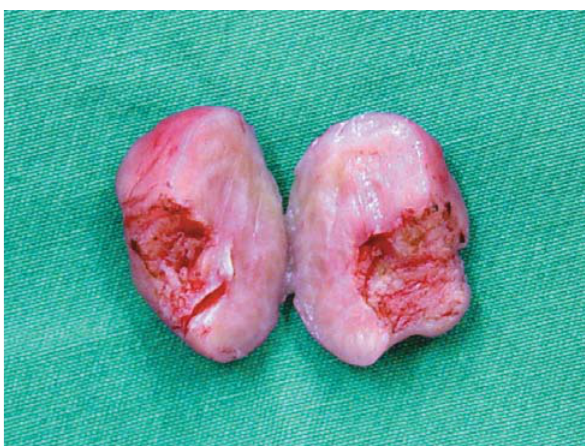
Fig. 3 – Análise macroscópica da massa endurecida e homogenia após ressecção da região pediculada